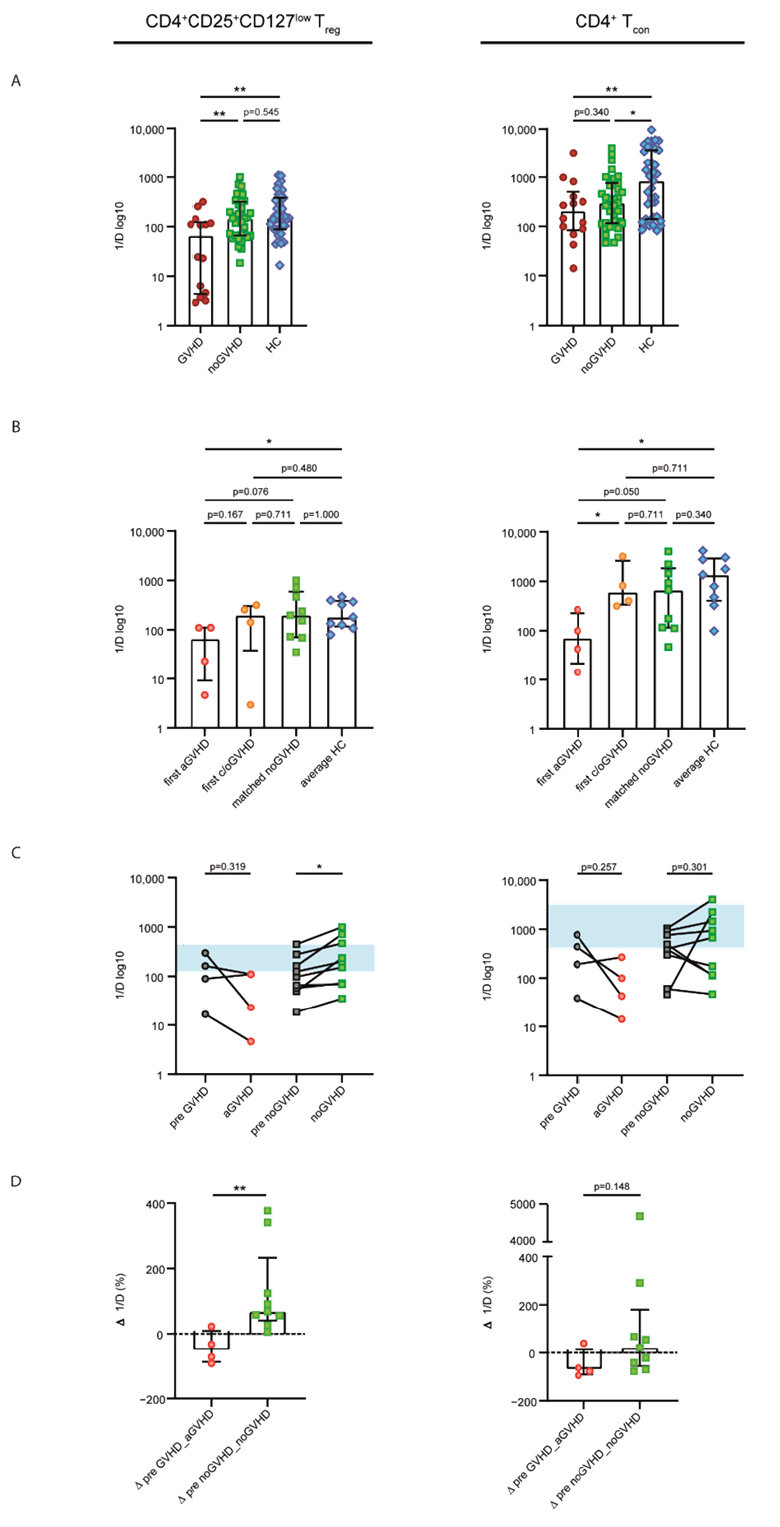
+ CD25 + CD127 low T + T reg and CD4 con